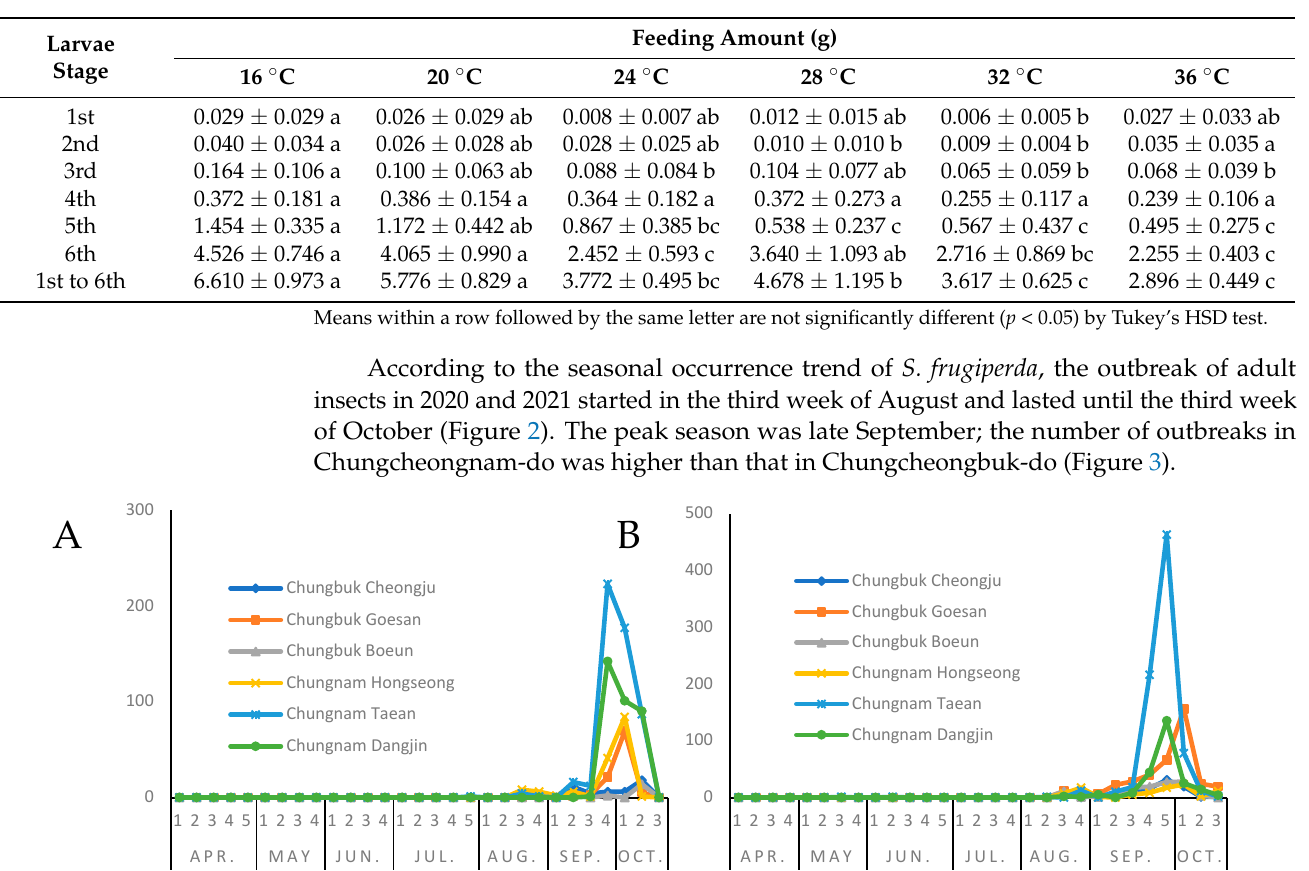
Table 4. Corn leaf feeding amount (mean ± SD) by the development stages of Spodoptera frugiperda according to temperature.